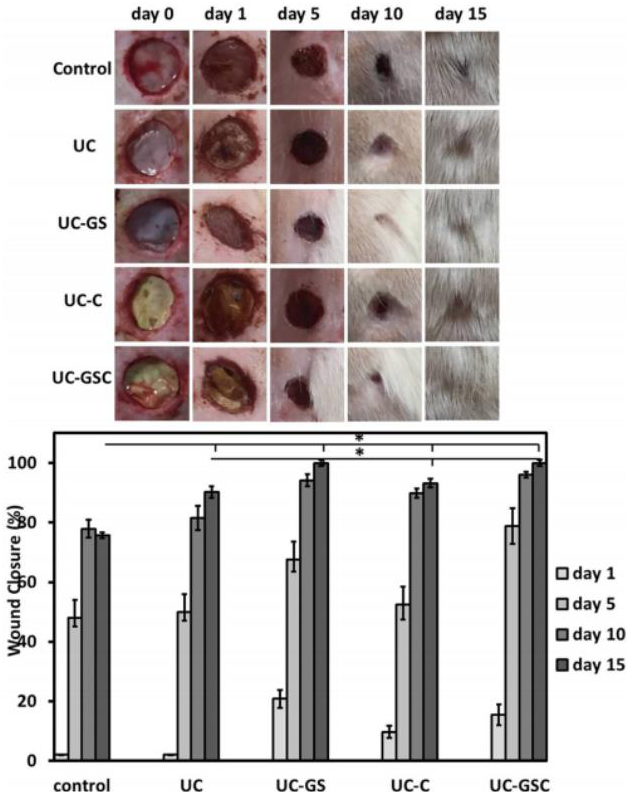
Figure 4. Visual observation and quantitative evaluation of healing wounds treated with the polyurethane/cellulose acetate named UC, where the UC contained rGO/Ag nanocomposites; UC-GS, where the UC contained curcumin; UC-C, where the UC contained rGO/Ag nanocomposites; and curcumin, UC-GSC [88]. *: These two samples were tested uder the same conditions and showed a fast healing rate compared to the others.